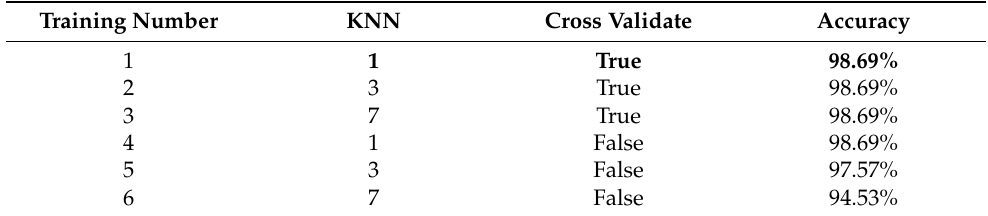
Table 7. k-NN algorithm hyperparameter optimization results using Euclidean as the distance function.